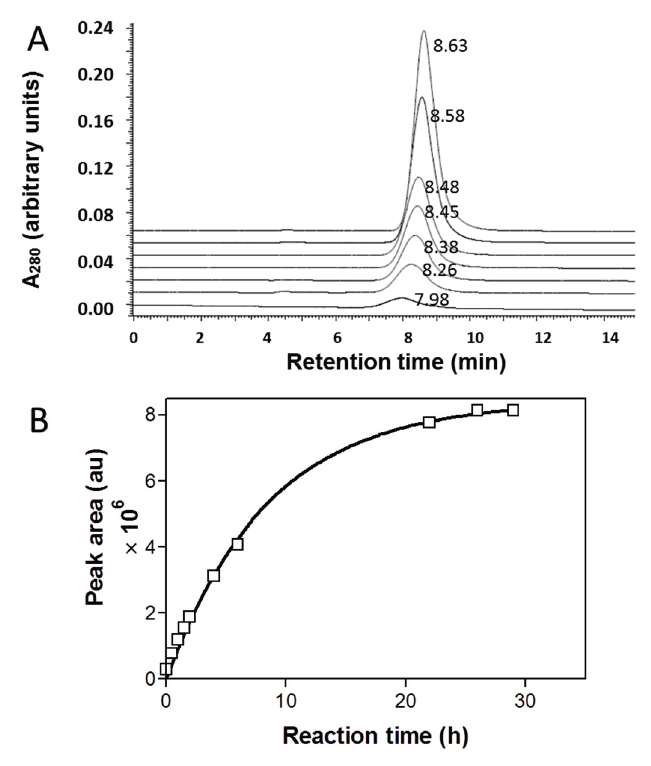
Figure 3. Kinetics of PMLA cleavage under condition of standard ammonolysis. At various times (bottom 0, 0.5, 1, 1.5, 2, 4, and 6 h top), samples were analyzed by SEC-HPLC and retention time is indicated next to each peak ( A ); The areas under the peaks were plotted against incubation time ( B